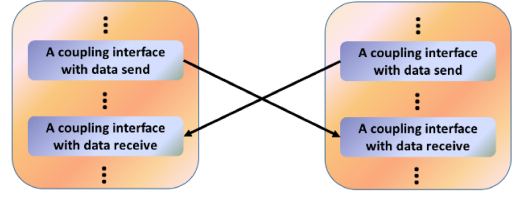
Figure 3. Example of model coupling between two component models: deadlocks occur when blocking data send/receive opera- tions are